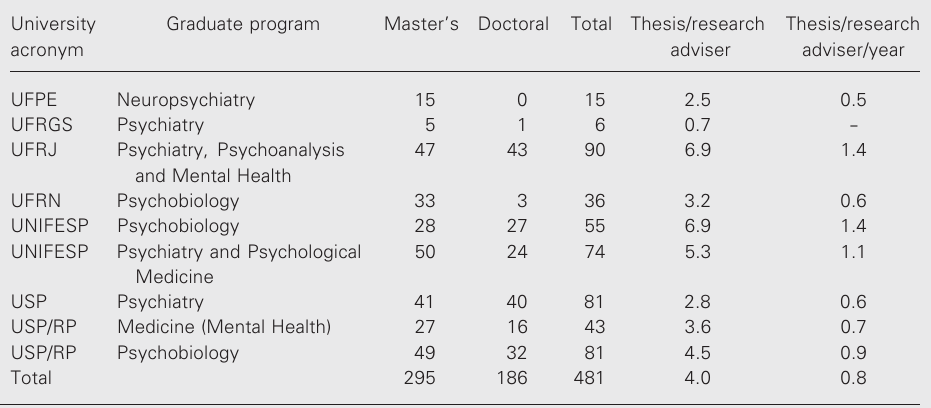
Table 2. Productivity of the graduate programs in Psychiatry and related areas during